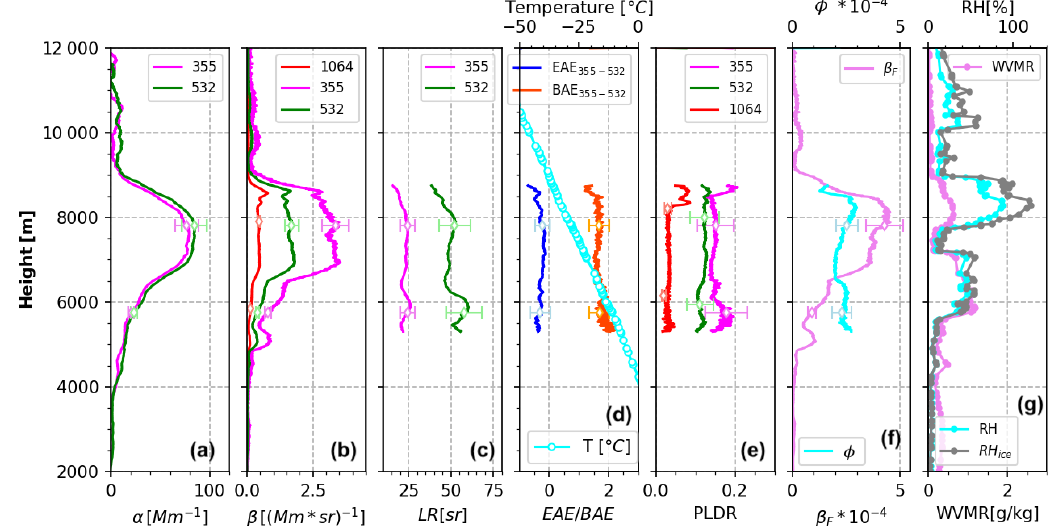
Figure 10. The same as Fig. 8 except for observations between 22:30UTC, 17 September 2020, and 03:00UTC, 18 September 2020. The radio sounding measurements are from Herstmonceux, England, which is about 200km from the observation site. Radio sounding at Beauvechain, Belgium, was not available on that day.